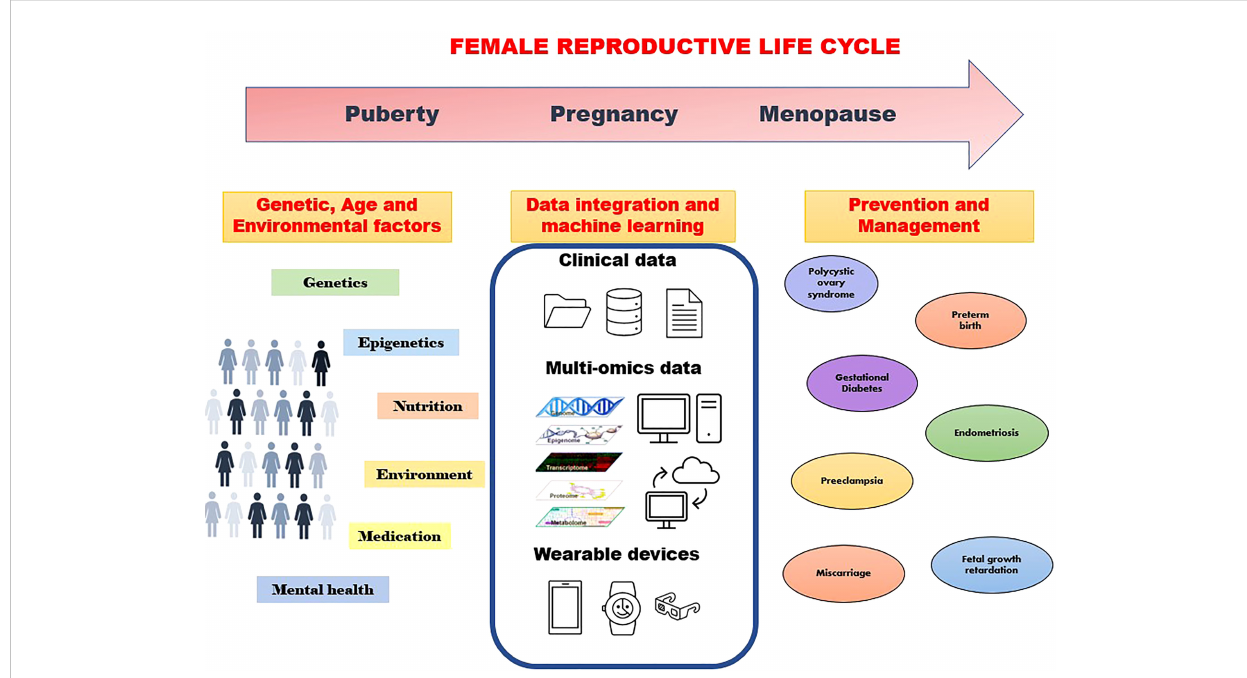
FIGURE 1 Machine learning approaches using various data to understand genetic and environmental factors towards prevention and management of disorders through the family reproductive life